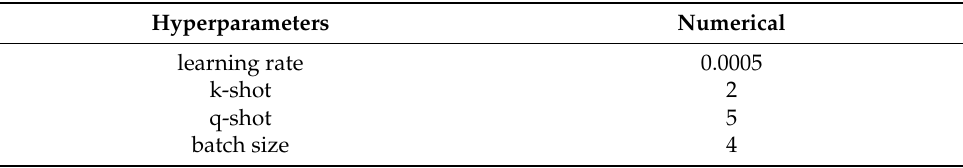
Table 2. Hyperparameters of